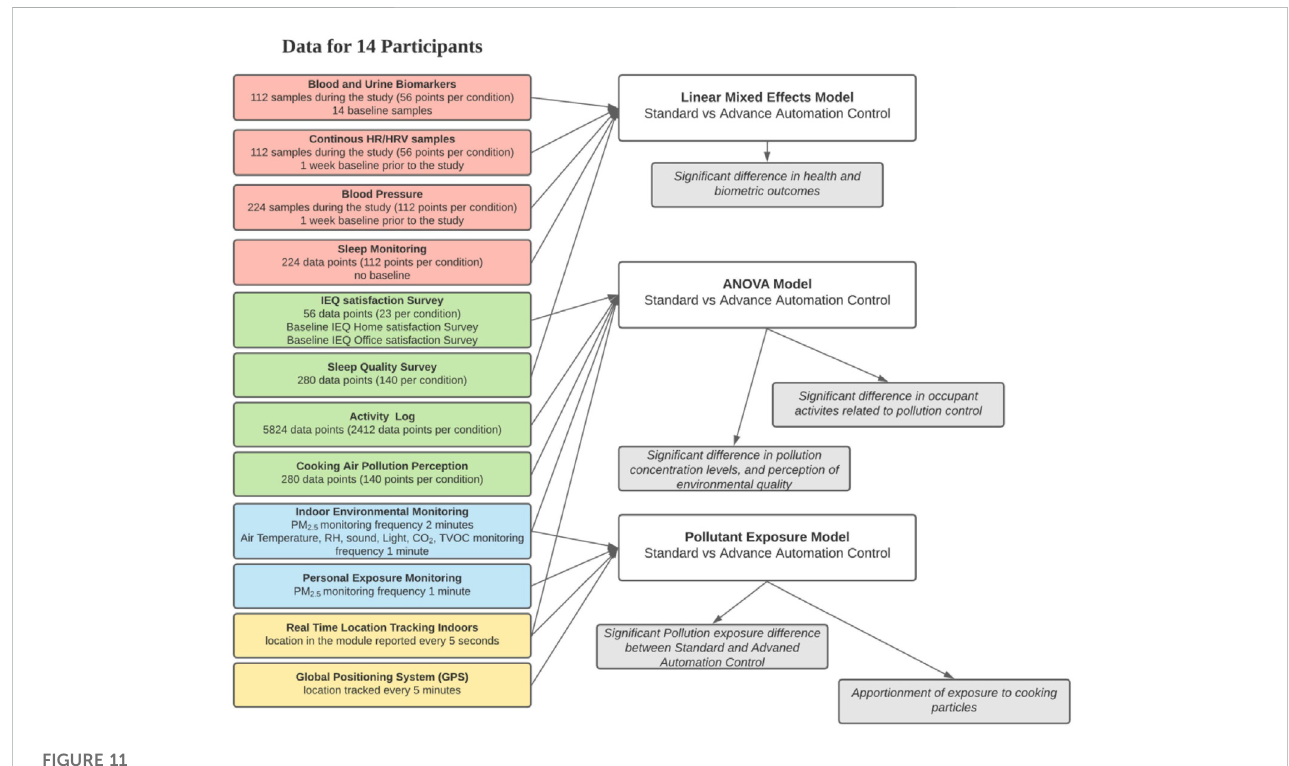
FIGURE 11 Data analysis